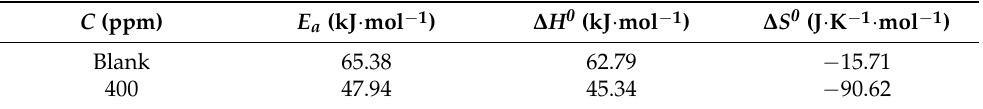
Herein, N and h are Avogadro’s number (6.02 × 10 23 ) and Planck’s constant (6.626 × 10 − 34 J · s), respectively. Figure 10b presents the plots of ln V corr